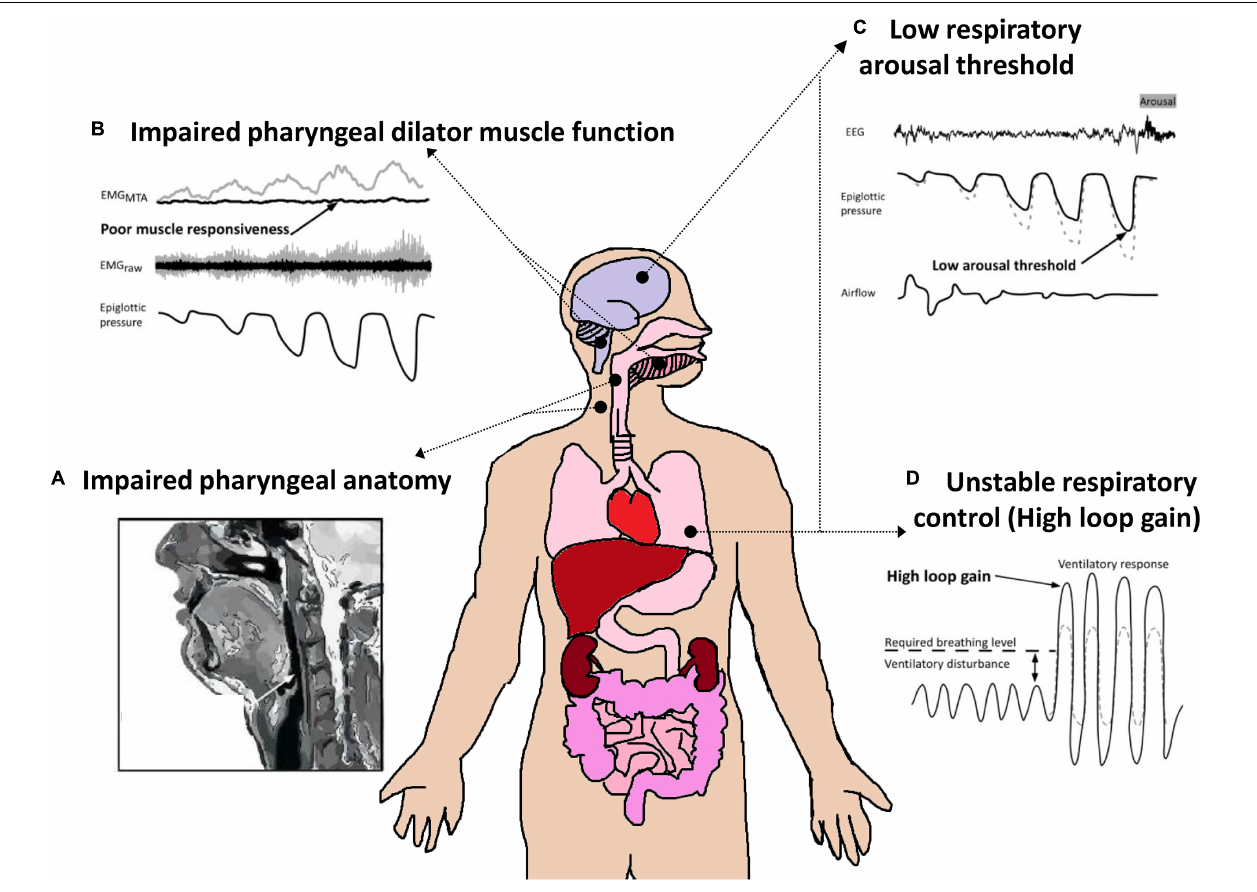
FIGURE 5 | Schematic of the four key endotypic traits that contribute to OSA pathophysiology. (A) Impaired pharyngeal anatomy/collapsible upper airway. Non-anatomical endotypes include: (B) Poor pharyngeal dilator muscle function including poor responsiveness/activation to negative pharyngeal pressure/airway narrowing, (C) a low respiratory arousal threshold (waking up too easily to minor pharyngeal narrowing events); and (D) Unstable respiratory control/increased sensitivity to minor changes in CO 2 (high loop gain). Each of these endotypes is a target for therapy or a “treatable trait.” Adapted from Carberry et al. (2018) and Aishah and Eckert